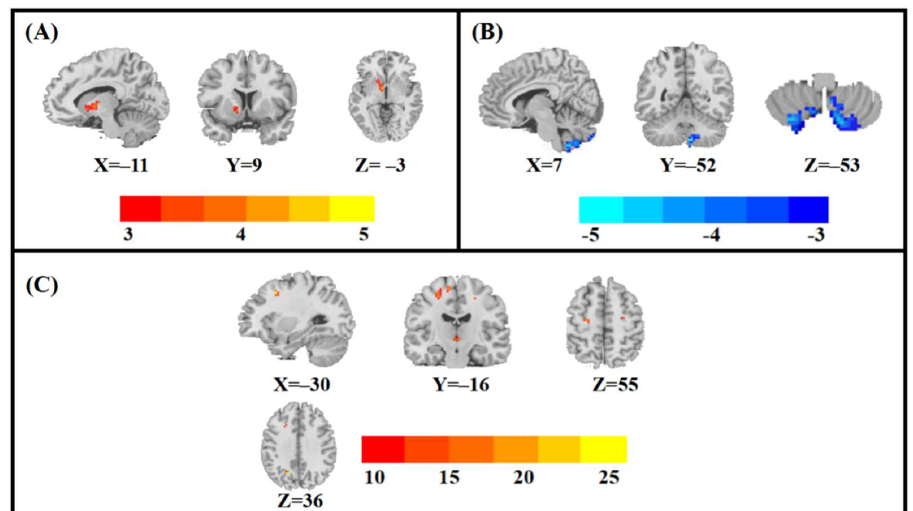
Figure 1. Statistical maps showing significant ALFF differences among the four group. ( A ), Main